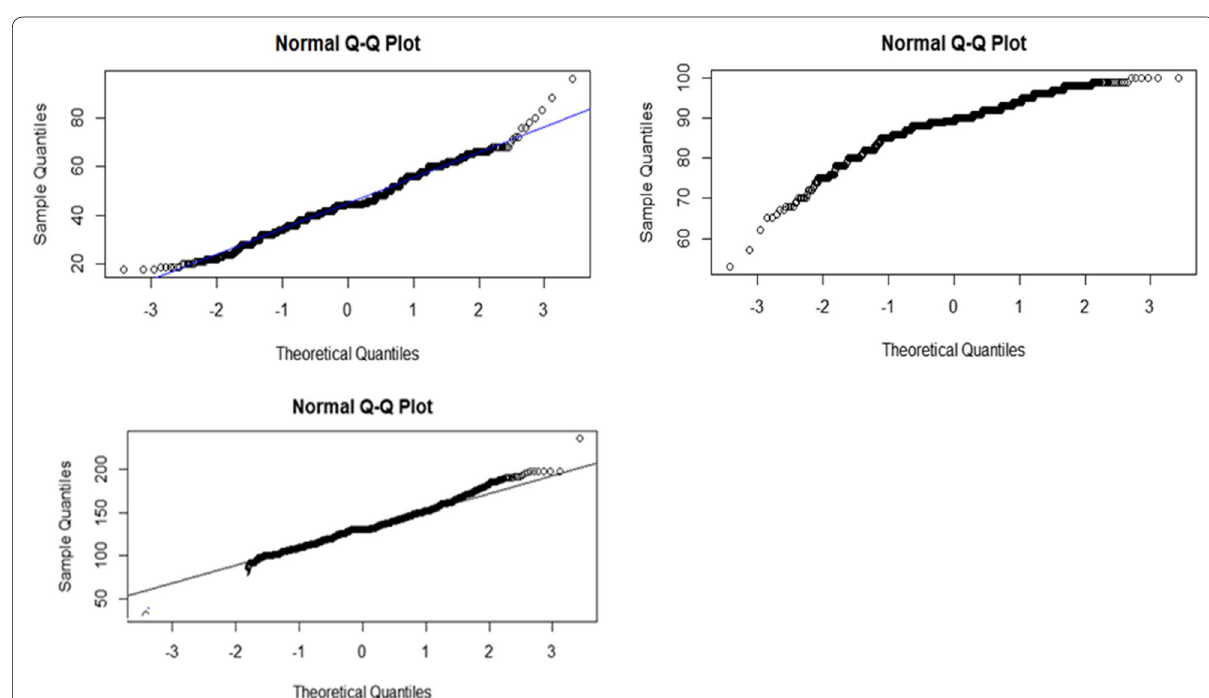
Fig. 1 Normal QQ plots of RR, PR and oxygen